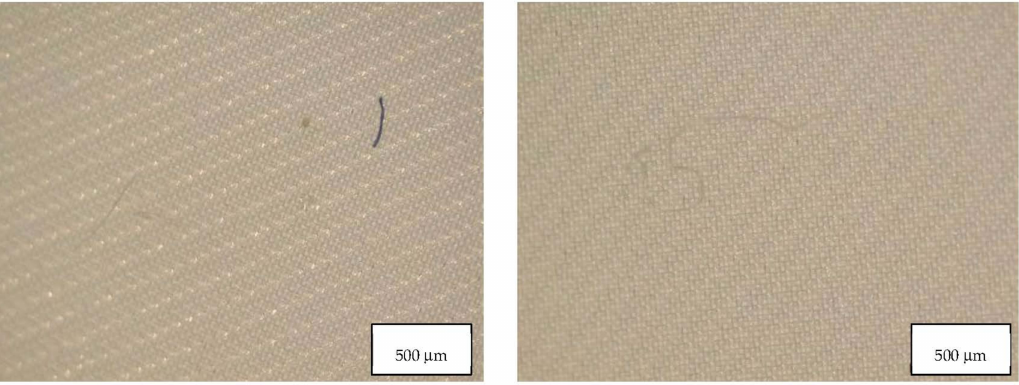
Figure 6. Microplastics detected in the filter of Blank 2 seen at the stereomicroscope with scale bar of 500 µ m.